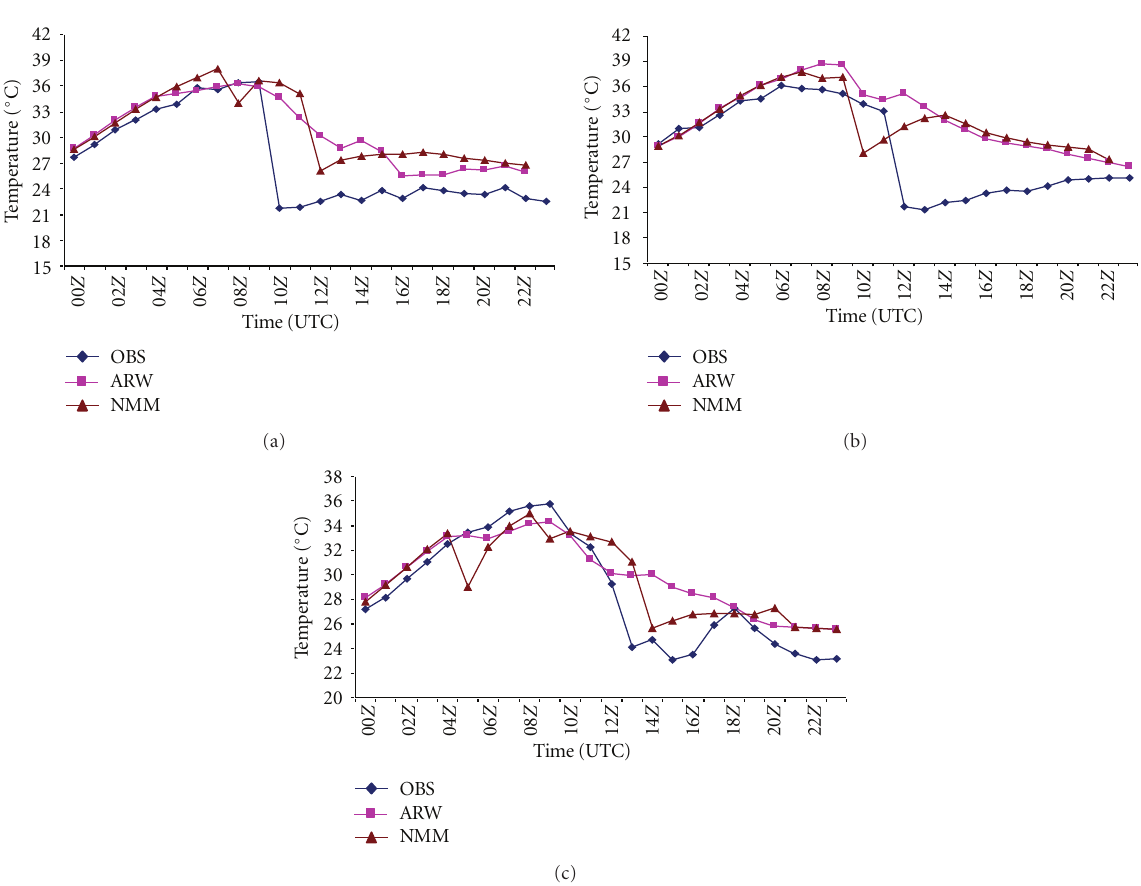
surfaces near the ground, purely isobaric above a prescribed pressure value (typically about 420 hPa), and relax from terrain following to isobaric over the intervening depth. Fur- ther details of the vertical coordinate can be found in [23], while ARW model’s vertical coordinate is a terrain-following hydrostatic pressure